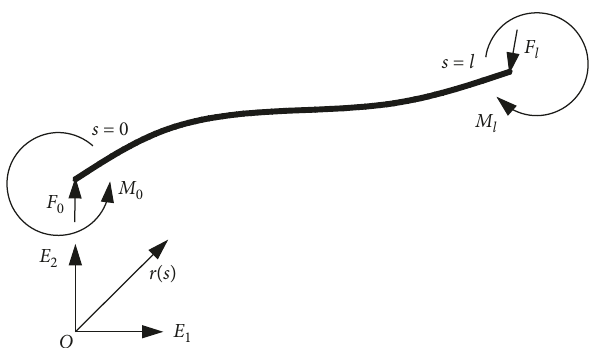
Figure 8: At s � 0, F 0 and M 0 are the terminal force and terminal moment, respectively; at s � l , F l and M l are the terminal force and terminal moment; and at point s � ξ , F ξ is the force.